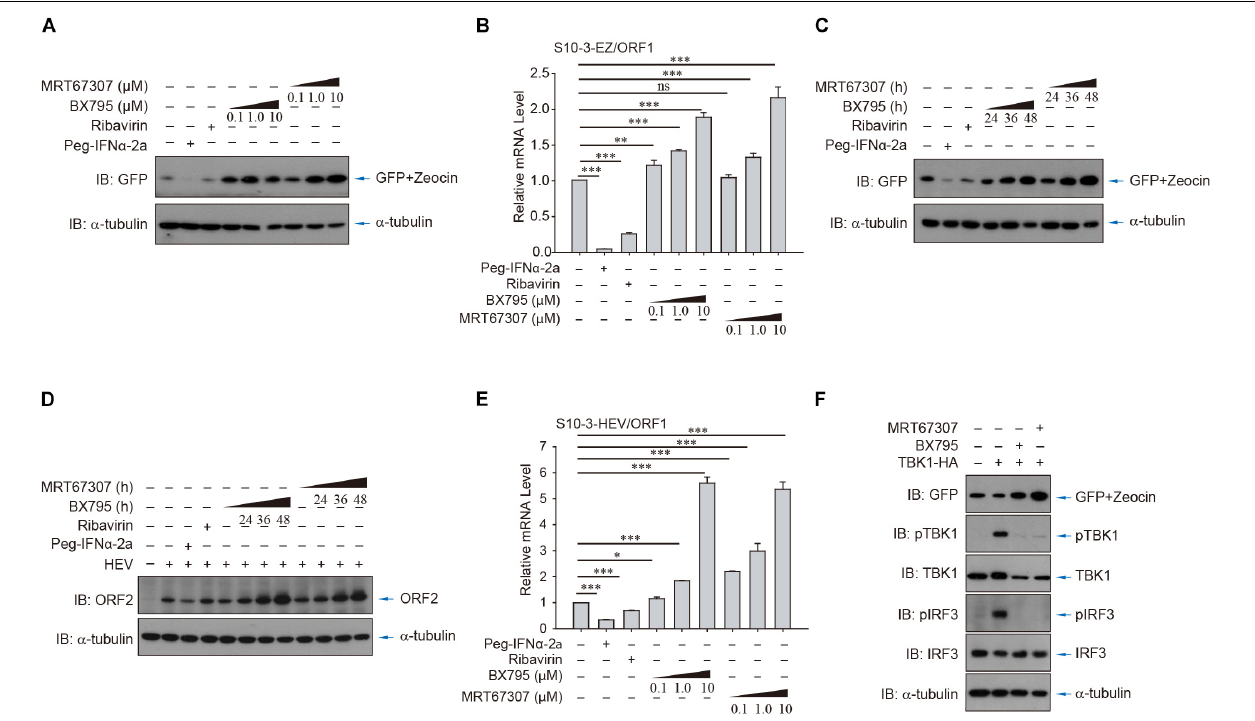
FIGURE 6 | HEV interferes with host antiviral sensing and responses in HEV replicon cells or persistent HEV-infected S10-3 cells. Treatment with TBK1 inhibitors BX795 or MRT67307 in persistent HEV replicon cells S10-3-EZ enhanced GFP expression, in both (A) a dose-dependent and (C) time-dependent manner. (B) In these same cells, BX795 or MRT67307 increased HEV replicon RNA level in a dose-dependent manner. (D,E) S10-3 cells stably infected with HEV p6 stock (S10-3-HEV) were established as described (Yin et al., 2017), and expression of (D) ORF2 protein or (E) ORF1 RNA was determined by western blot or qPCR, respectively. (F) Overexpression of TBK1 in persistent HEV replicon S10-3-EZ cells led to the activation of antiviral responses and a decrease in HEV replication. The mean ± SEM is shown, and error bars indicate standard deviation; unless otherwise specified, n = 3 independent experiments. Analysis of variance (ANOVA) tests were performed with Bonferroni correction; * P < 0.05; ** P < 0.01; and *** P < 0.001.